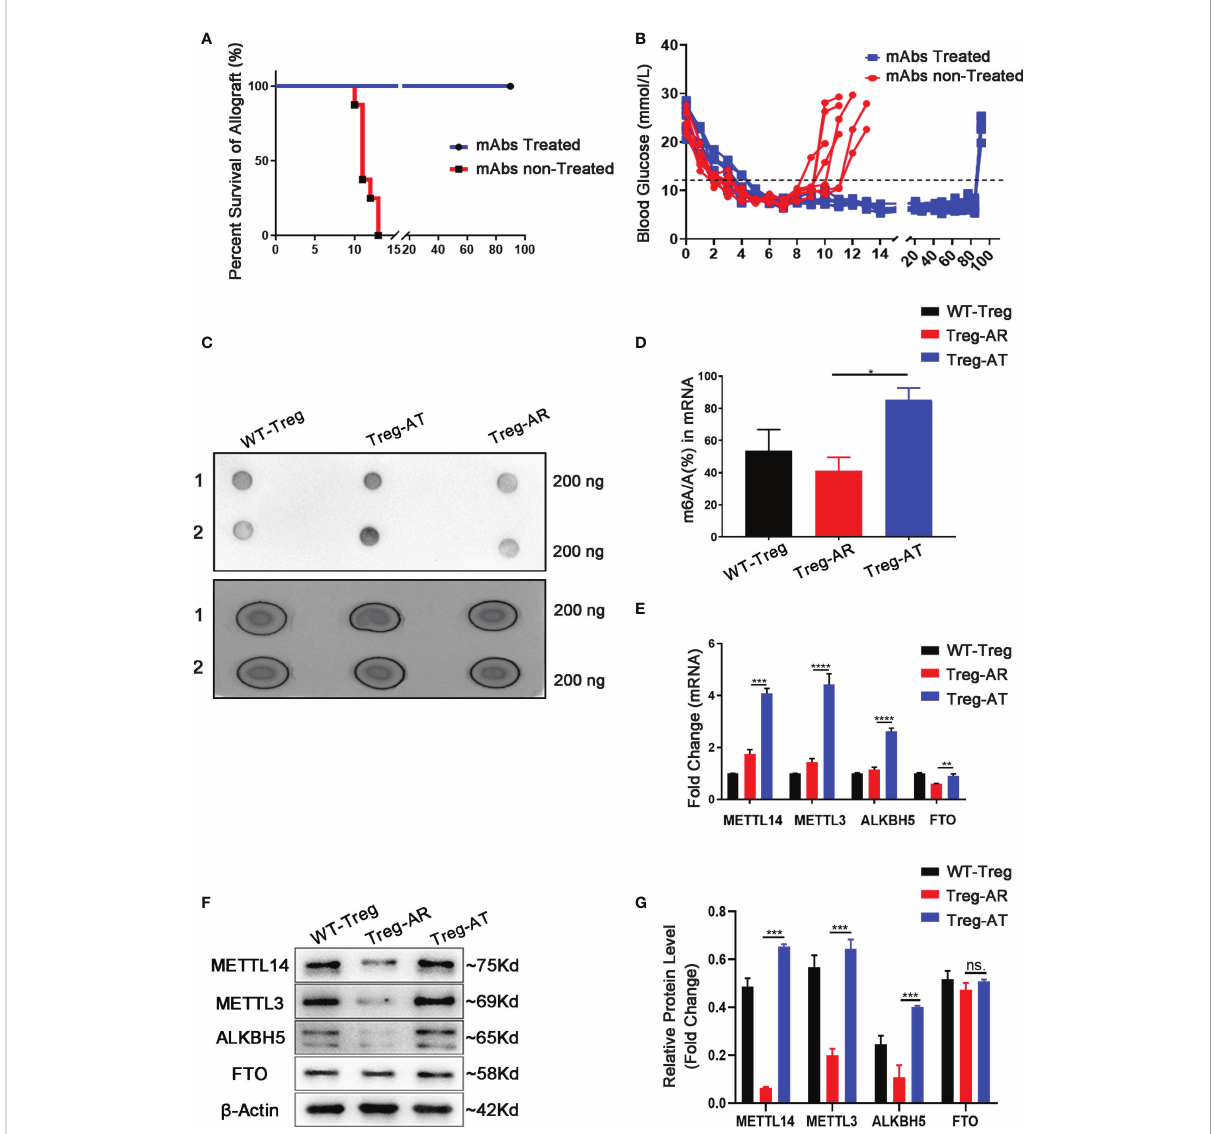
FIGURE 1 The level of the m6A modi fi cation increases in Treg cells from allograft tolerant group. (A) Islet allografts (BALB/c mice to C57BL/6J mice) displayed long-term graft survival in all recipients (n=7, 100%) under anti-CD45RB and anti-CD40L monoclonal antibodies (mAbs) treatment (blue line). Without mAbs treatment, the islet allografts were rejected within 13 ± 2.2 days (red line). (B) Blood glucose levels in recipients represent the function of islets allograft post-transplantation. Diabetic mice transplanted islets and treated with mAbs maintained the long-term allograft function as an allograft tolerance (AT) group (blue line), and splenic-derived Treg cells were isolated on day 90 days after transplantation as Treg-AT cells. Without mAbs treatment, the recipients rejected islets allograft rapidly and was referred to as the allograft rejection (AR) group (red line). The splenic-derived Treg cells were isolated from the recipients with two successive non-fasting blood glucose concentrations exceeding 11.1 mmol/L as Treg-AR cells. (C, D) The global m6A level in total RNA isolated from Treg cells (including Treg-AR cells and Treg-AT cells) was measured using dot blotting. (E) The mRNA levels of m6A regulators were measured by using qPCR, and METTL14, METTL3, and ALKBH5 levels were signi fi cantly decreased in the Treg-AR group, compared to those in the Treg-AT group. (F, G) Western blot analysis indicated that the METTL14, METTL3, and ALKBH5 protein levels were signi fi cantly decreased in the Treg-AR group compared to those in the Treg-AT group. The data are shown as the means ± SD and are representative of three separate experiments. The data in (E) depict the mean mRNA expression normalized to the Gapdh mRNA. The data in (G) depict the mean protein expression normalized to the gene b -Actin The statistical analysis was performed with an unpaired Student ’ s t-test (two-tailed). ****P<0.0001, ***P<0.001, **P<0.01, *P<0.05. P values >0.05 were considered nonsigni fi cant